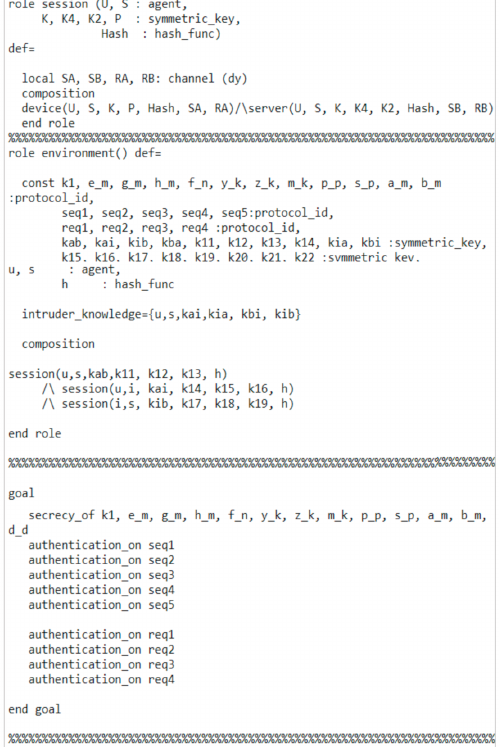
Figure 6. Role specification for IoT devices.